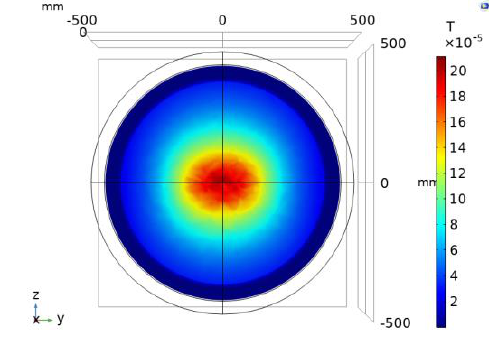
Figure 16. Square coil.